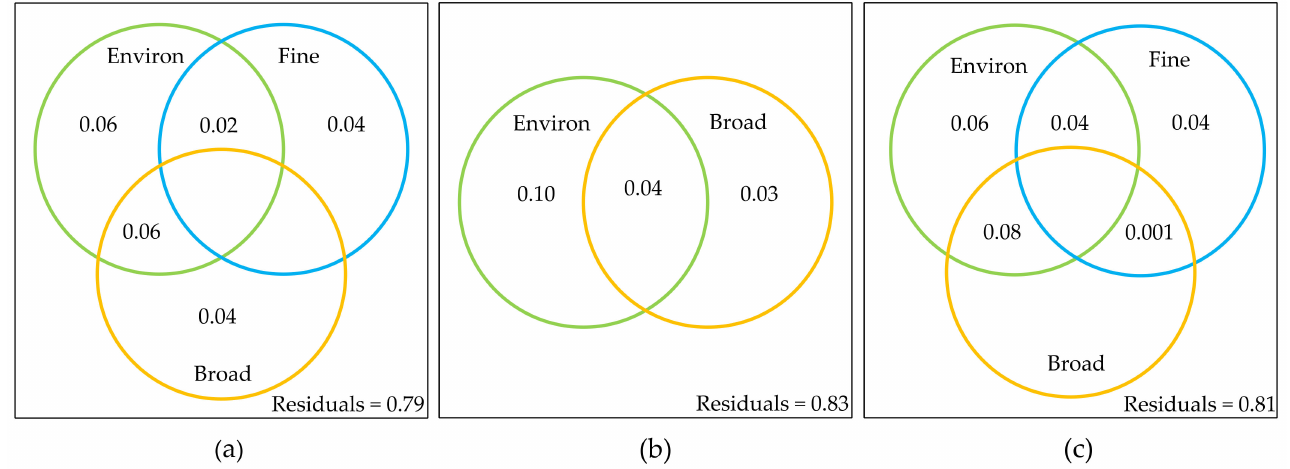
Figure 2. Venn diagram of the variation partitioning among environmental (Environ) and spatial variables (fine and broad scale) for total zooplankton ( a ), branchiopods ( b ) and copepods ( c ). Adjusted R 2 is shown. Values < 0 are not